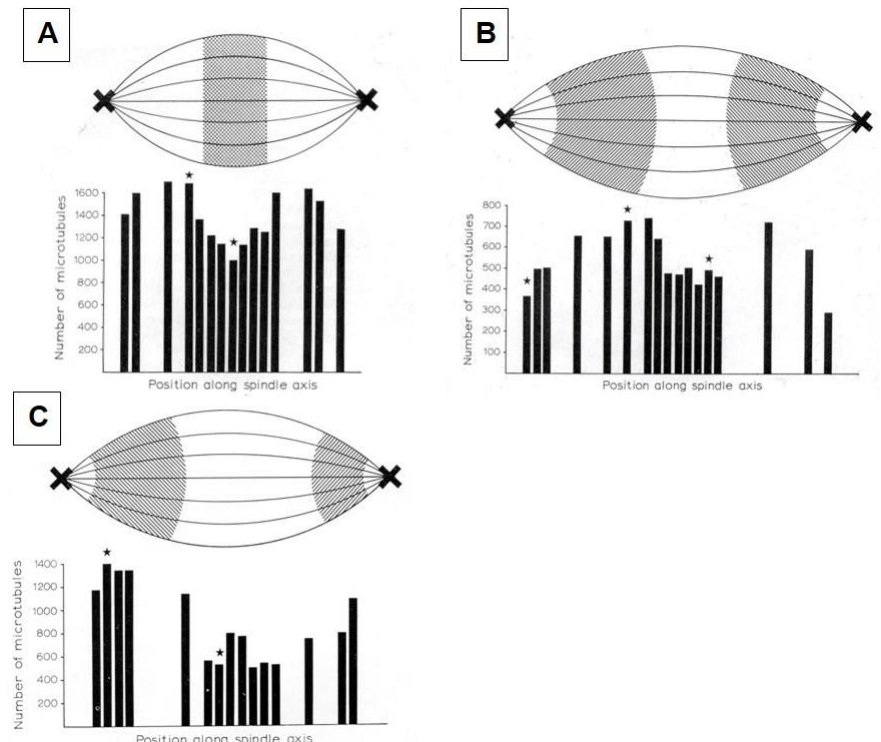
Figure 11. Counts of total numbers of MTs seen on successive spindle cross-sections from pole to pole at three stages of mitosis: ( A ) = metaphase; ( B ) = early anaphase; ( C ) = mid anaphase. From McIntosh and Landis, 1971 [34]. This image is displayed under the terms of a Creative Commons License (Attribution-Noncommercial-Share Alike 3.0 Unported license, as described at http://creativecommons. org/licenses/by-nc-sa/3.0/.